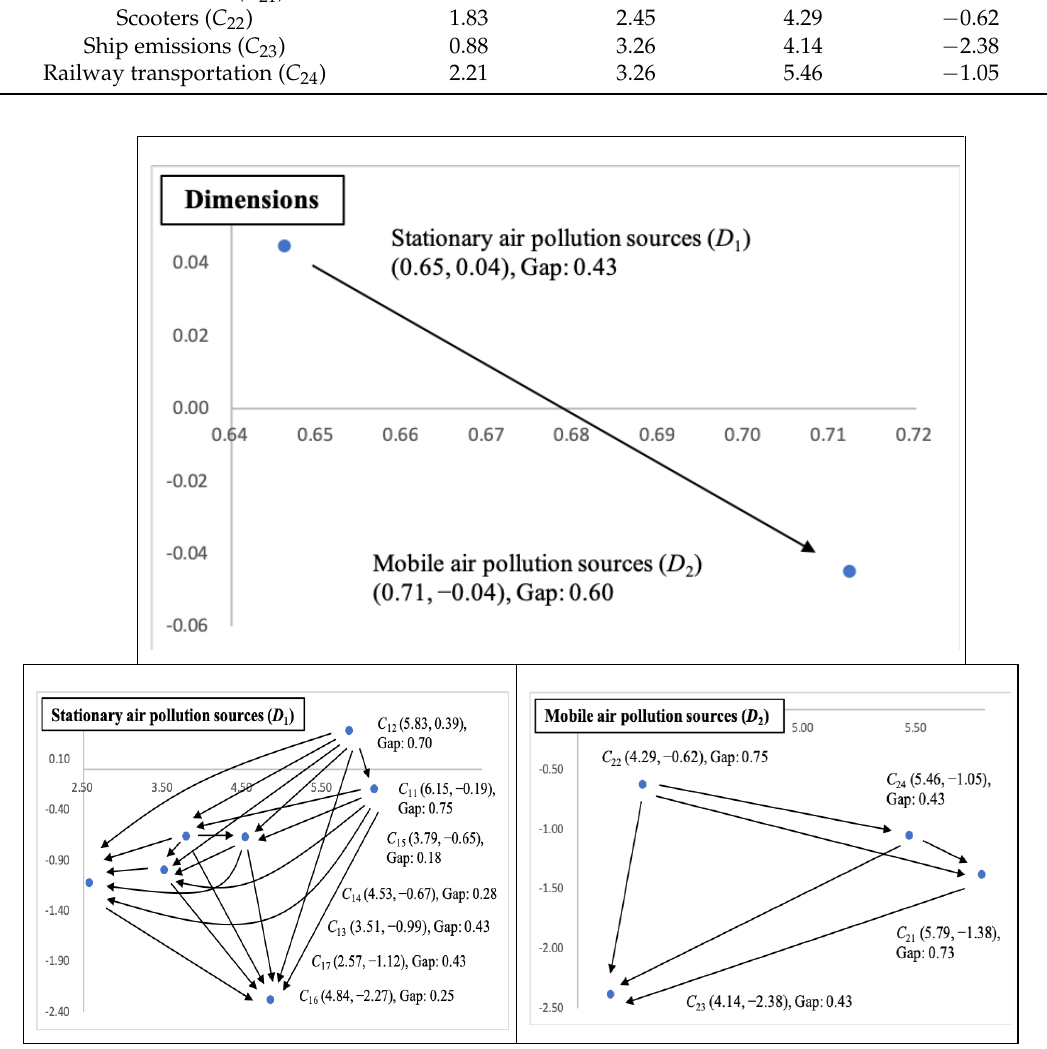
Figure 2. INRM of dimensions and criteria.